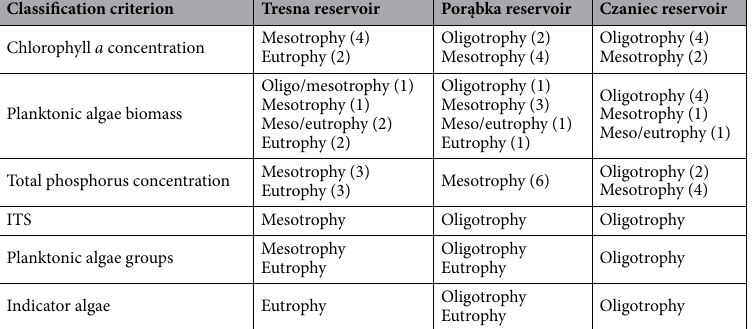
Table 4. Trophic states of the Soła cascade reservoirs in 2019